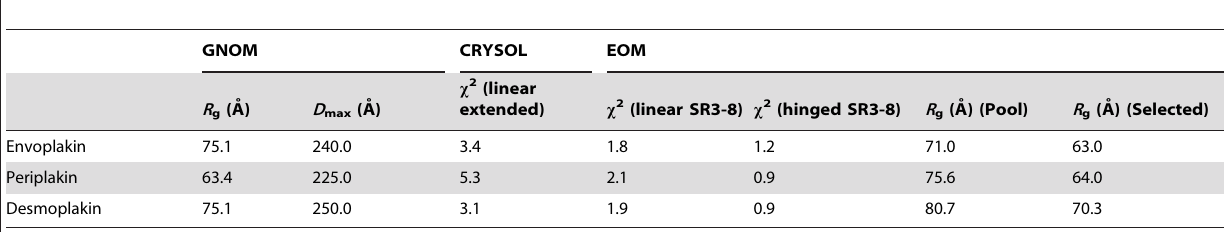
Table 2. R g and D max values for each plakin